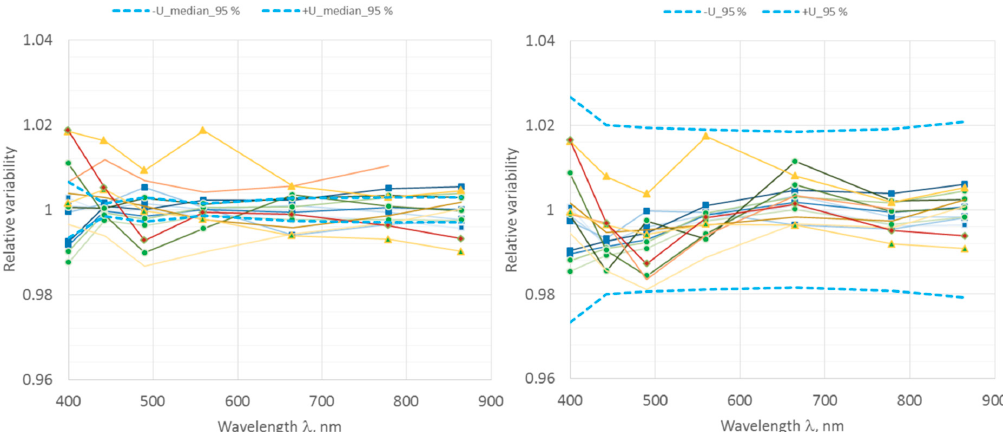
Figure 9. ( left ) Comparison of each participating irradiance sensor measuring an irradiance source compared to the median over all instruments; after reviewing data by pilot, corrections submitted by participants and/or unified data handling by pilot with blue dotted lines the expanded uncertainty of the median consensus value; ( right ) compared to the reference values of the filter radiometer with blue dashed lines the expanded uncertainty covering 95% of all data points and uncertainty of radiometric calibration included. Reproduced with permission from [45].